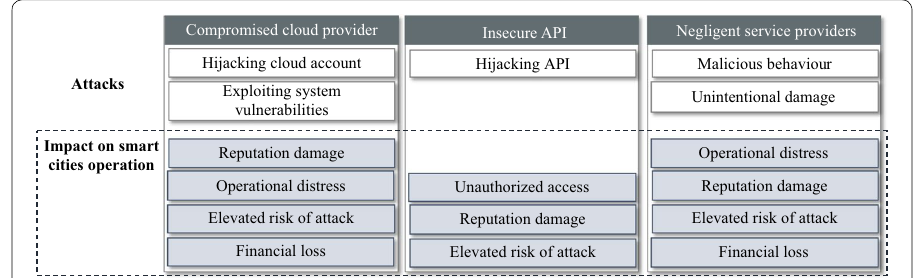
Fig. 7 Third‑party vulnerabilities threatening smart cities: attacks and